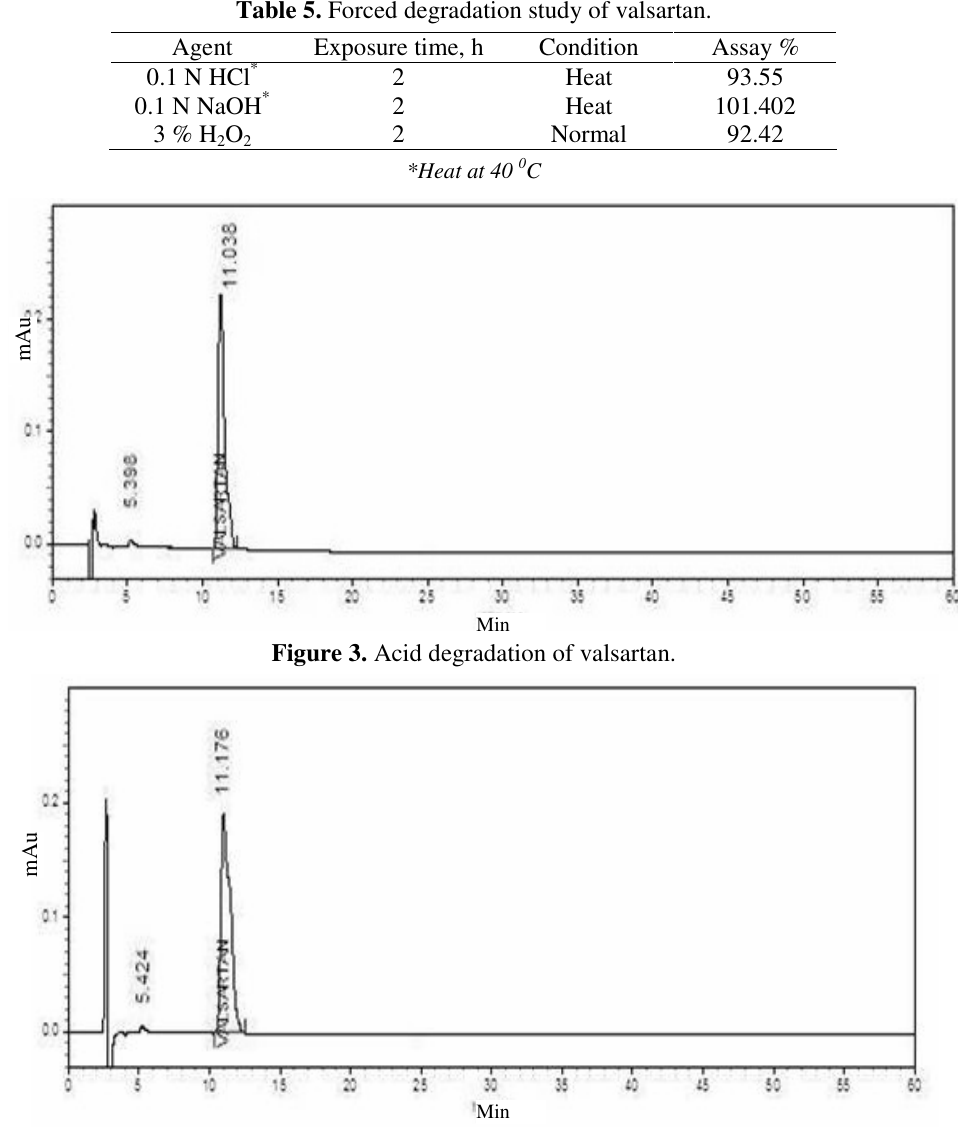
Figure 4. Basic degradation of